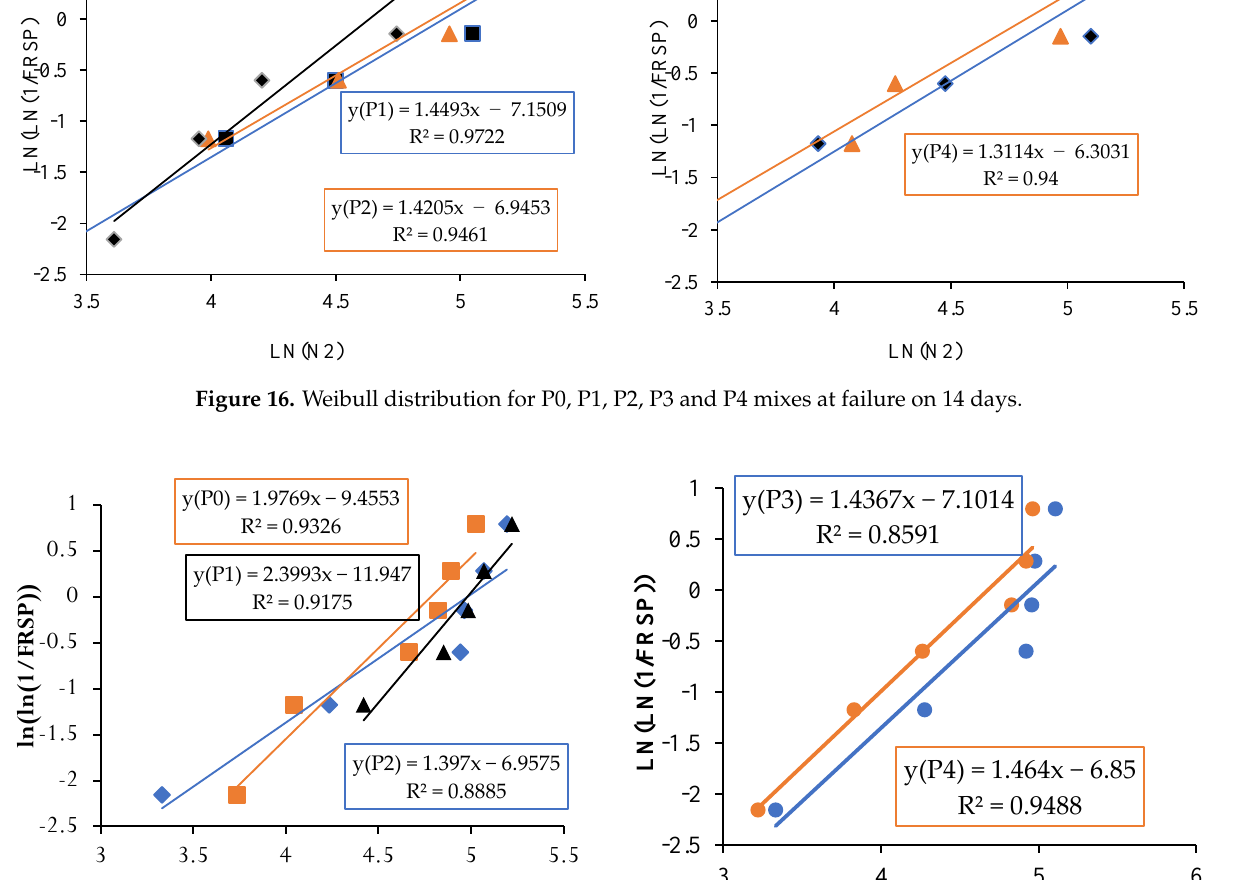
Figure 16. Weibull distribution for P0, P1, P2, P3 and P4 mixes at initial crack on 28 days.